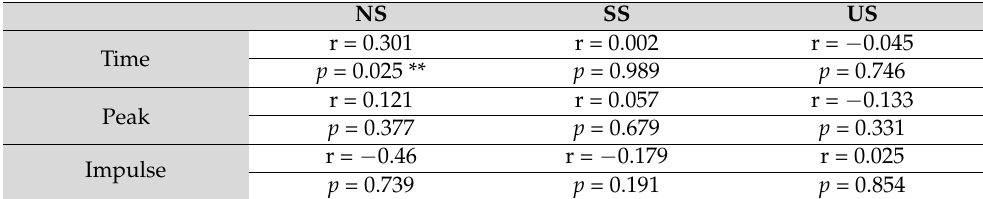
Table 1. Pearson’s correlation values for slip time, peak, and impulse values between pressure sensor data and GRF data (NS: normal socks, SS: silicone socks, and US: urethane socks; r: correlation coefficient; **: p < 0.05).